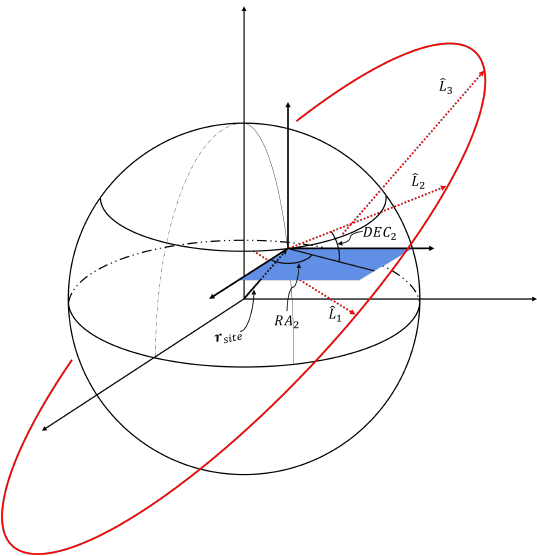
Figure 1. Geometry of angles-only Initial Orbit